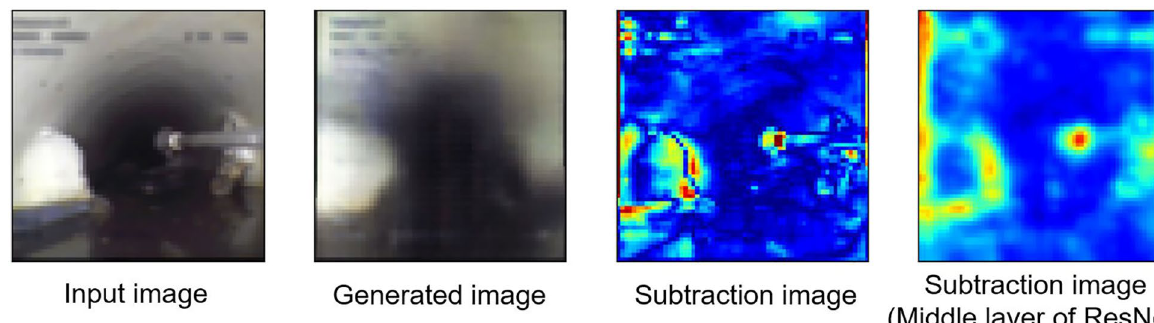
Fig. 22 Experimental results of obstacle anormaly pipe (VAE)